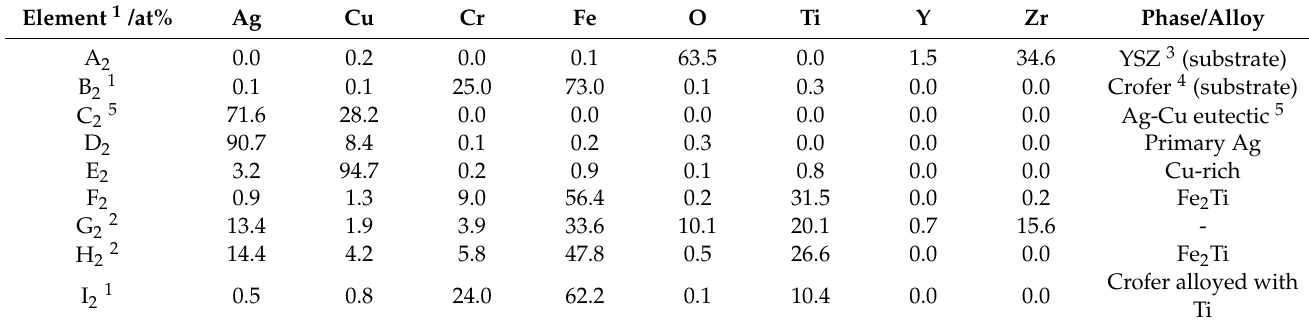
Table 3. EPMA WDS quantitative chemical analyses of BJ-2 in Figure 6b–d.